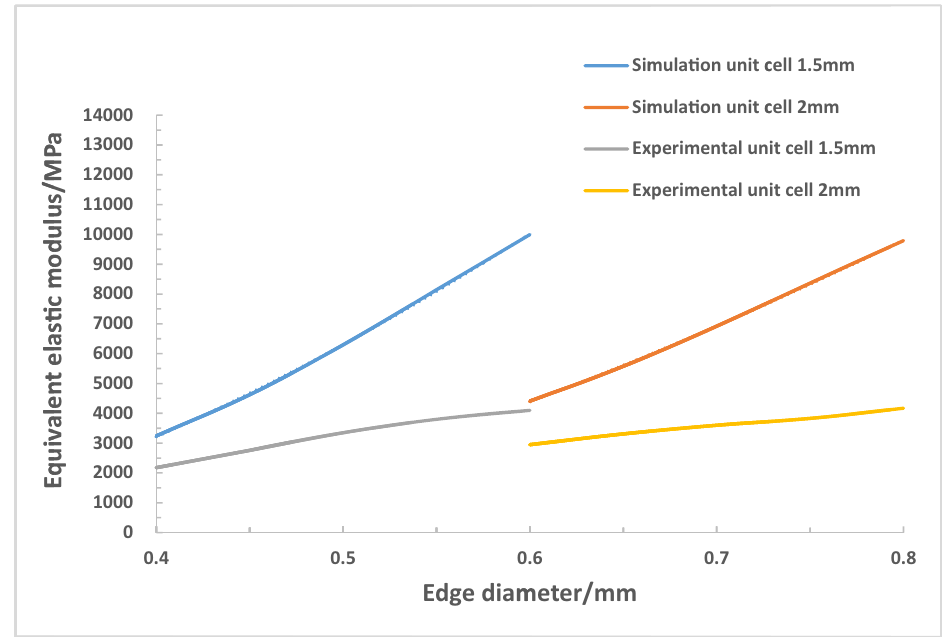
Figure 16: In fl uence of edge diameter on equivalent elastic modulus.